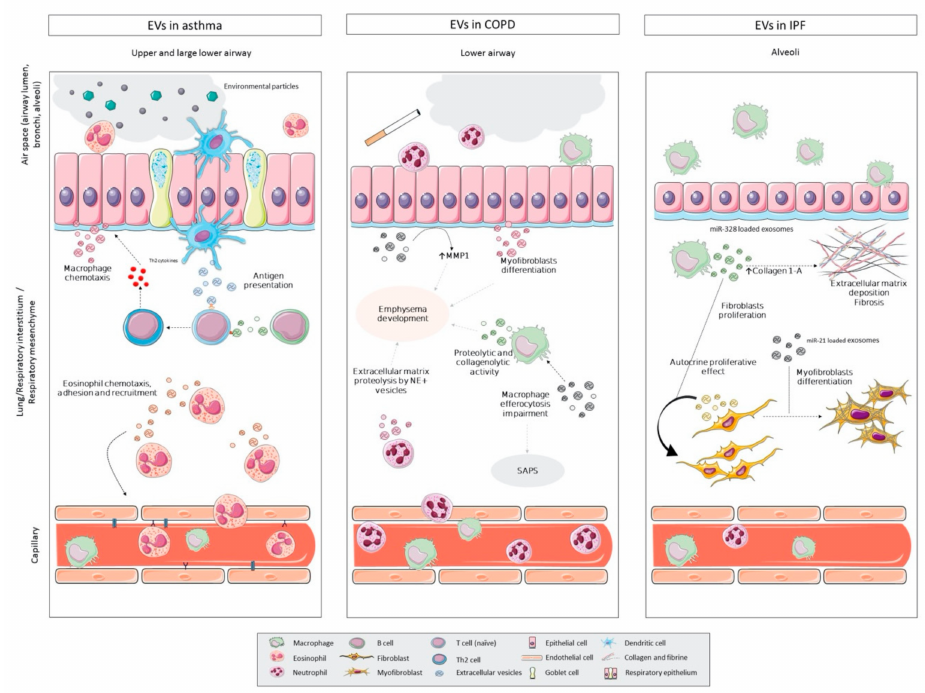
Figure 3. Summary of some of the main reported roles of extracellular vesicles (EVs) in the pathophysiological mechanisms of asthma, chronic obstructive pulmonary disease (COPD) and interstitial pulmonary fibrosis (IPF). The figure shows the cellular origin of the EVs as well as their cellular destiny or their main action. In the upper and large lower airway of asthma patients, EVs contribute to antigen presentation, EVs from endothelial cells participate in macrophage chemotaxis while eosinophil EVs could act in their own chemotaxis, adhesion and recruitment. In COPD, EVs could promote emphysema development increasing MMP1 secretion in lung epithelial cells, through myofibroblast differentiation or enhancing the proteolysis of the extracellular matrix. In the alveoli of IPF patients, EVs from macrophages could increase the collagen 1-A expression in fibroblast, increasing the extracellular matrix deposition, as well as promote fibroblast proliferation. (Components of this figure have been obtained and modified from Servier Medical Art, https://smart.servier.com, with permission under the Creative Commons Attribution 3.0 Unported